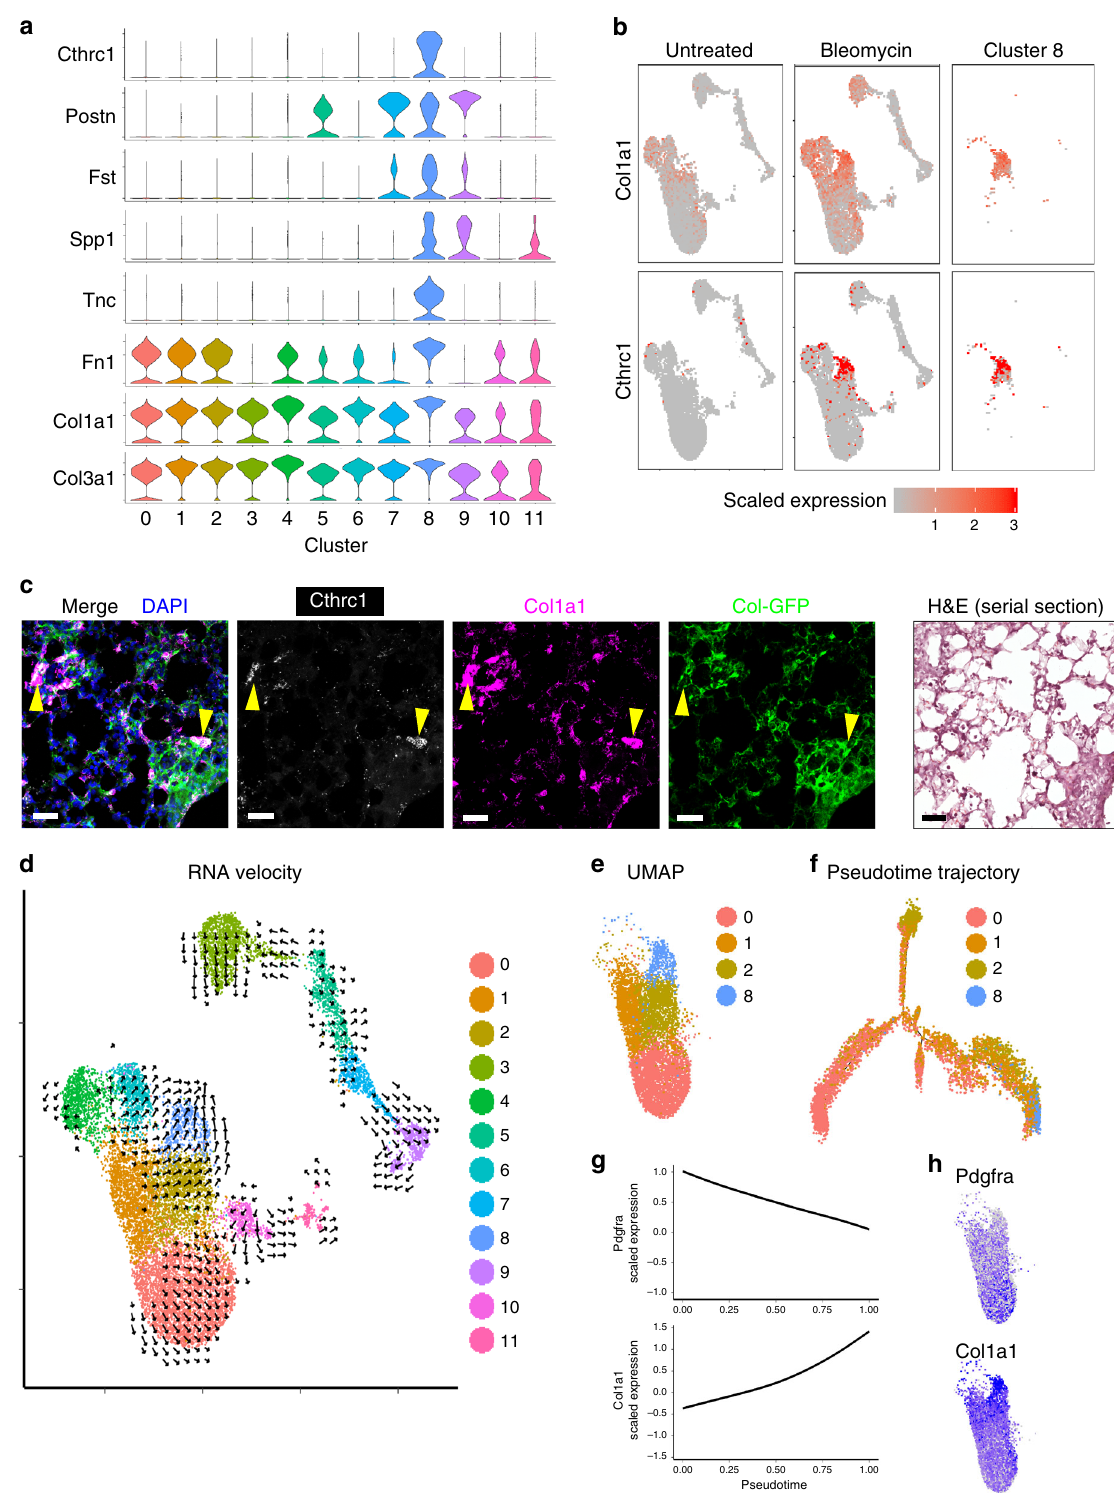
Fig. 4 Cthrc1 + cells express pathologic ECM genes in fi brotic lungs. a Violin plots showing markers of cluster 8. b Expression levels of Col1a1 and Cthrc1 on UMAP plots. Cells from untreated lungs, bleomycin-treated lungs, or cluster 8 are shown separately in each column. c PLISH images for Cthrc1 (white) or Col1a1 (magenta) 14 days after bleomycin treatment. Col-GFP is shown in green. DAPI signal is shown in blue. H&E staining of serial section is also shown. Arrowheads indicate co-localization of Cthrc1 and Col1a1 in GFP + cells. Scale bar, 50 μ m. Images are representative from three experiments ( n ≥ 2). d RNA velocity analysis overlaid on UMAP plot. Direction indicates transition towards the estimated future state of a cell. e UMAP plot showing only clusters 0, 1, 2, and 8. f Pseudotime trajectory analysis by Monocle 2. g Expression levels of Pdgfra and Col1a1 were analyzed along the pseudotime and fi tted cubic smoothing spline curves are shown. The y -axis is scaled gene expression level. h Pdgfra and Col1a1 expression levels on UMAP